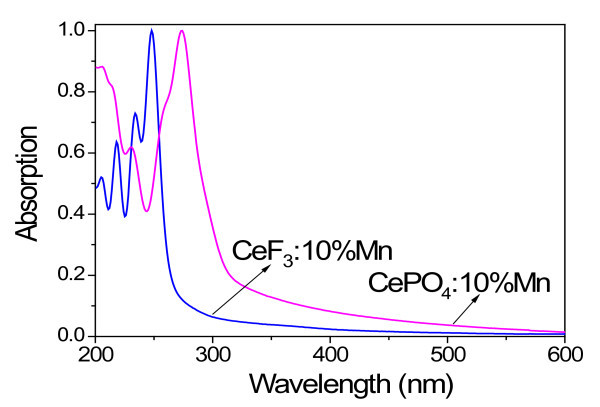
Absorption spectra attributed to electronic transitions. Absorption spectra of CeF3:Mn and CePO4:Mn NCs.